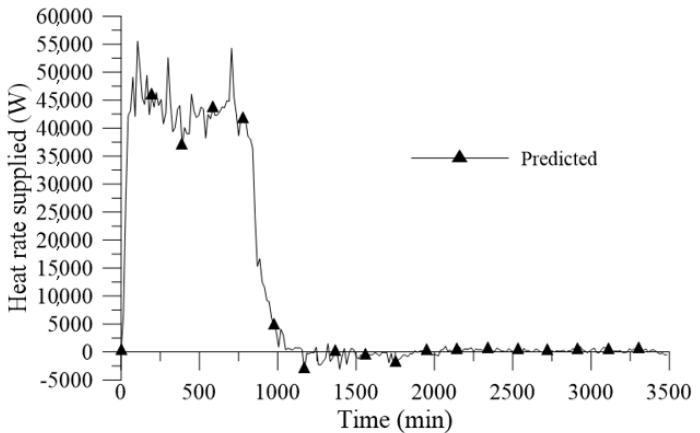
Figure 14. Heat rate supplied to the kiln as a function of Figure 14